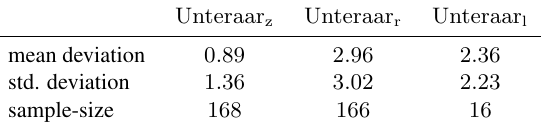
Table 1: Deviations of the control sample set of the manual mea- surements (unit: pixel=m) Unteraar z Unteraar r Unteraar l mean deviation 0 . 89 2 . 96 2 . 36 std. deviation 1 . 36 3 . 02 2 . 23 sample-size 168 166 16